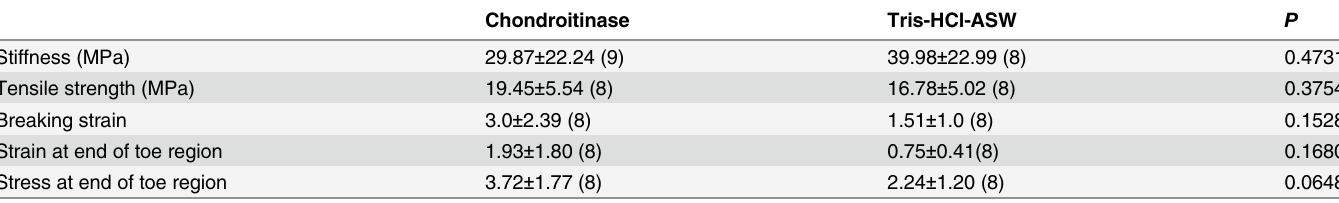
Table 2. Effects of chondroitinase ABC on the force-extension behaviour of P. lividus